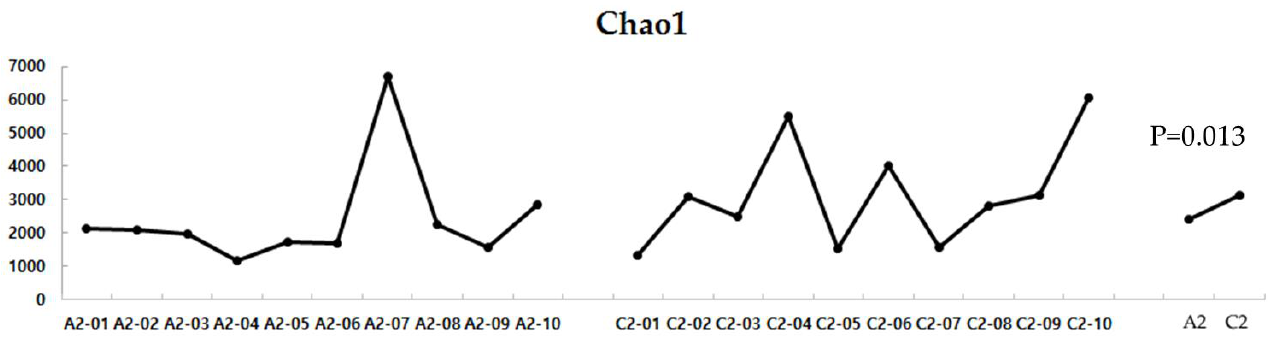
Figure 6. Alpha diversity of the UC and HC groups. UC, ulcerative colitis; HC, healthy control; A2, ulcerative colitis patient group; C2, healthy control